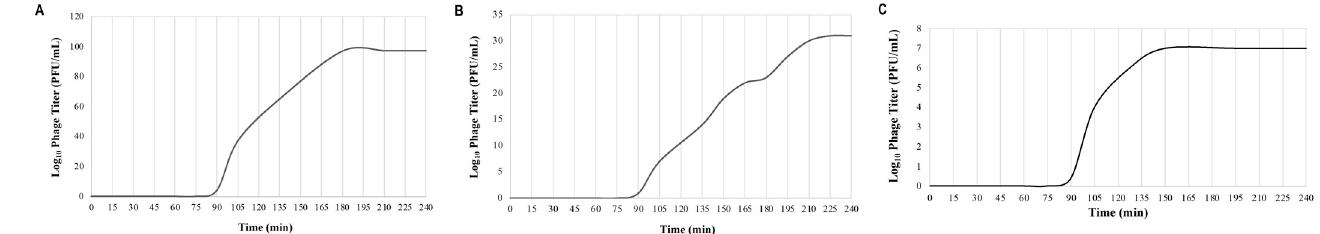
Figure 4. One-step growth curve assays depicting the life cycle of each phage on isolated host strain M. foliorum NRRL B-24224 at 30 °C for a 4 h duration: ( A ) KaiHaiDragon; ( B ) OneinaGillian; ( C ) YuuY.